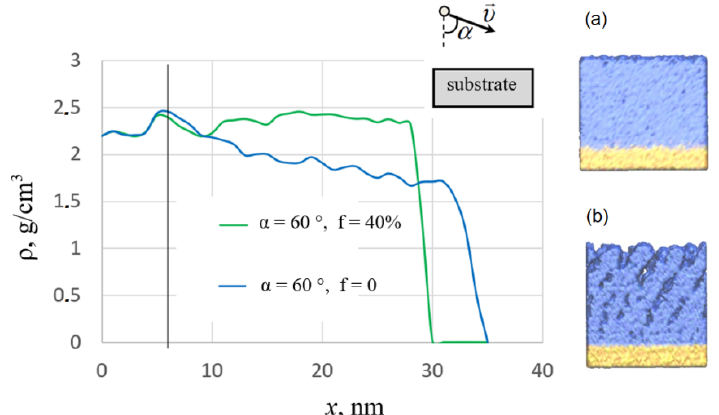
Figure 5. Dependence of the number of deposited atoms N at on the number of deposition steps N st . E = 100 eV.